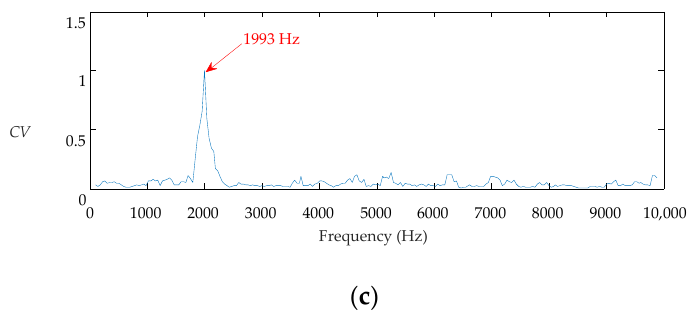
Figure 3. The results for the simulation signal: ( a ) time waveform, ( b ) FFT spectrum, and ( c ) CV vs. f c .